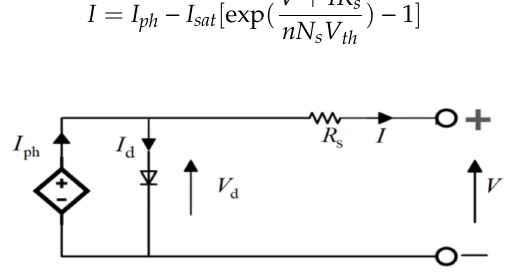
Figure 4. The four-parameters